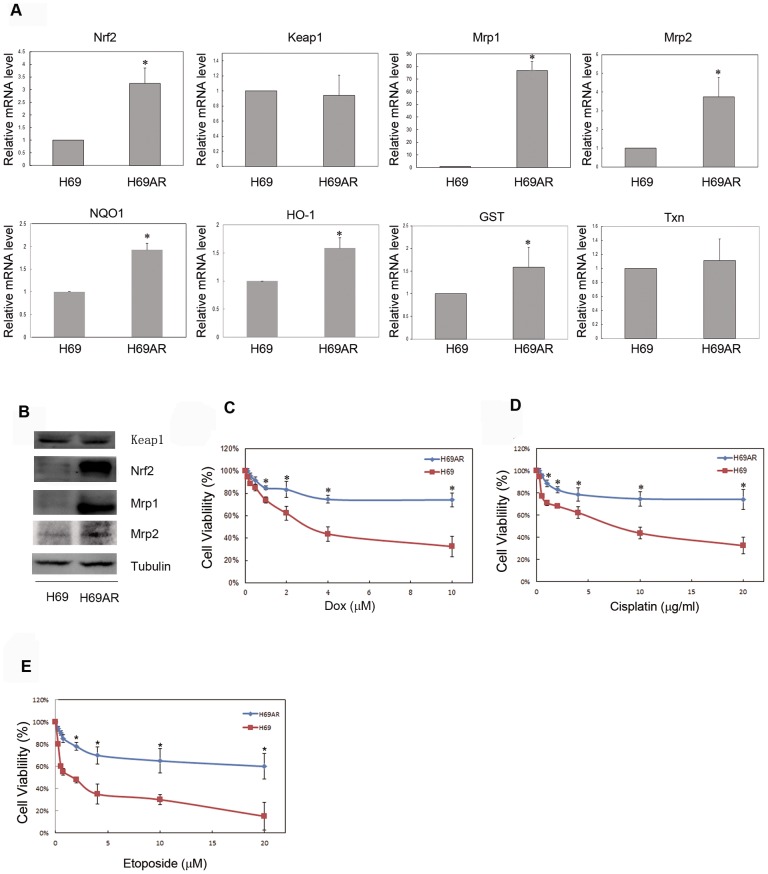
Nrf2 involves in the expression of Mrp1 and MDR in H69AR cells.(A) Relative mRNA level of Nrf2, Keap1, Mrp1, Mrp2, together with NQO1, HO-1, GST and Txn was compared in H69 and H69AR cells by real-time RT-PCR using the ΔΔCt method with GAPDH as an internal control. Results were expressed as mean ± SD from three independent experiments. (B) Protein level of Keap1, Nrf2, Mrp1, Mrp2 was compared in H69 and H69AR cells by Western blotting using Tubulin as internal control. Experiments were performed three times and a representative immunoblot was shown here. (C), (D) and (E) The viability of H69 and H69AR cells with treatment of Dox, Cisplatin and Etoposide in different doses for 24 hours was determined by MTT assay. The experimental differences were determined by two-tailed Student's t-test and p<0.05 was taken as a significant difference in all cases.